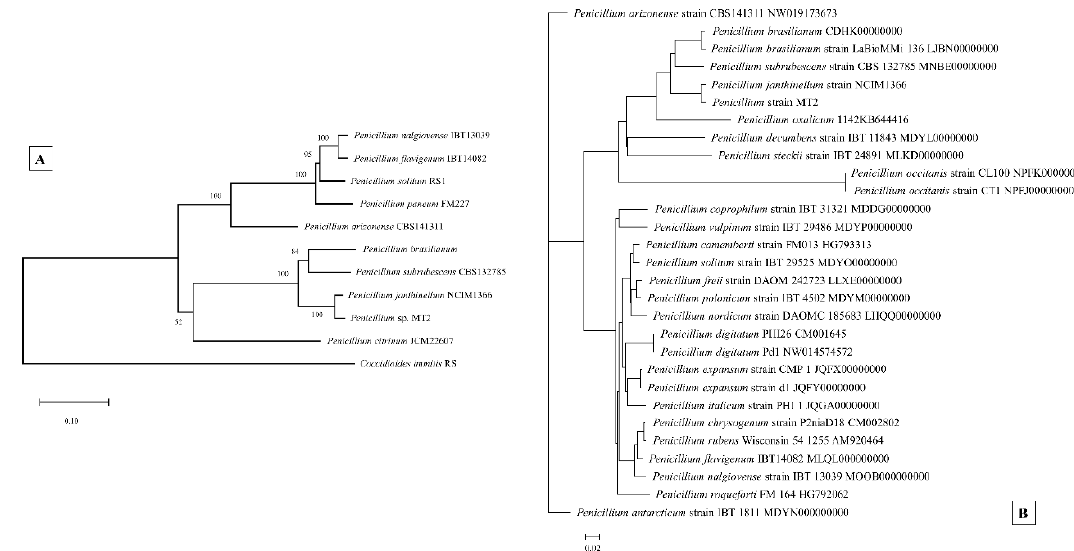
Figure 8. Shown is a phylogenetic tree constructed with maximum likelihood using concatenate sequences of the housekeeping genes Tsr1, Cct8, RPB1, and RPB2 ( A ), and ( B ), a genome-wide phylogenetic tree constructed with a cohort of 28 other sequenced Penicillium species available via the NCBI genome submission portal.